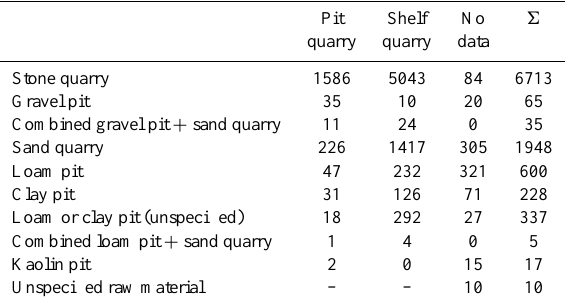
Table 2. Mining sites sorted by main used technologies. Note: “–” is the category of mining sites not classified in detail.